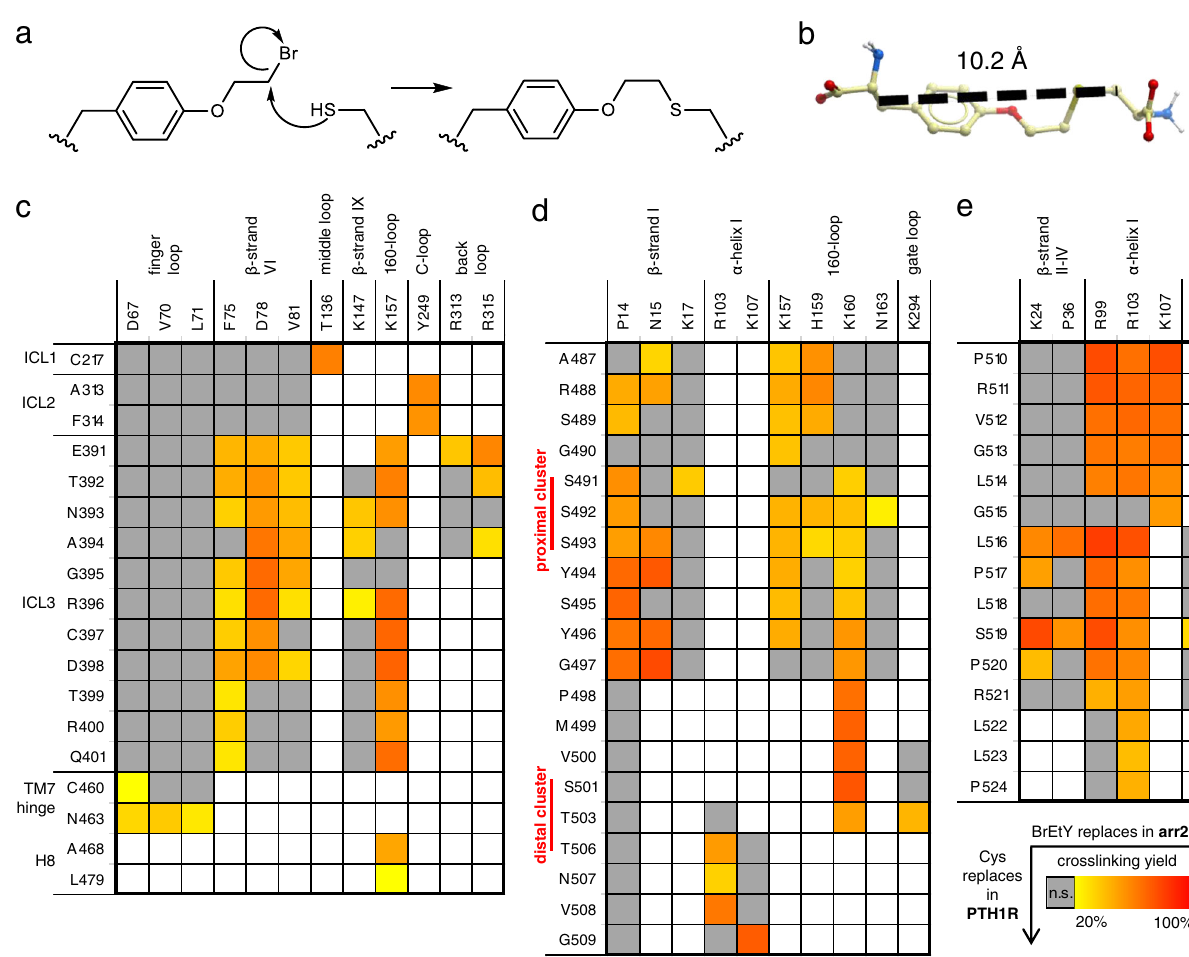
molecule. c – e Crosslinking matrix for Cys-PTH1R positions (row) with BrEtY-arr2 positions (column). Fields are colored according to the crosslinking yield of all combinations yielding signi fi cant signal over background noise ( n ≥ 3, see Sup- plementary Data 2). Gray squares indicate crosslinking signals not signi fi cantly different from control background noise, white indicate combinations that were not tested. All tested combinations are shown in Supplementary Figs. 6,